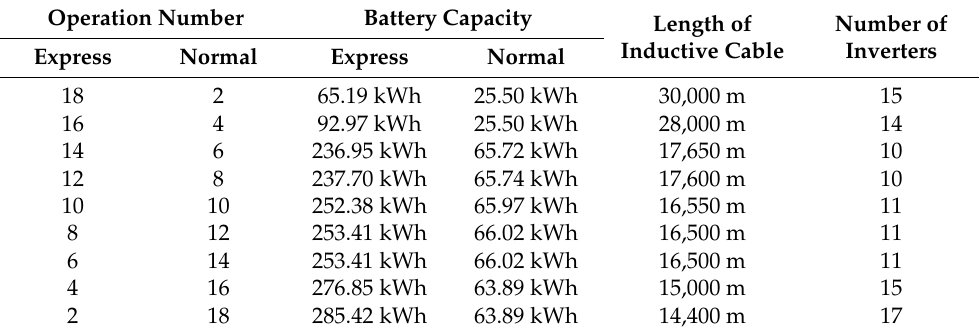
Table 6. Variation of the decision variables about the different operation ratios for the dual policy. Operation